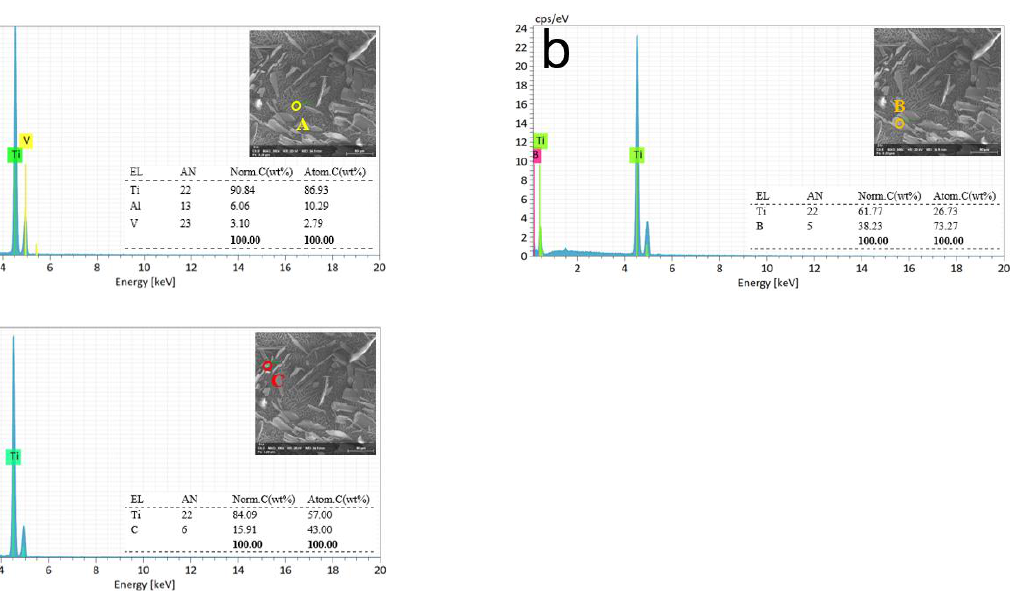
Figure 12. Energy spectrum analysis at different spots of processing time at 100 s. Different colored circles indicate measurement points at various locations. ( a ) Matrix material. ( b , c ) Reinforcing phase particles attached to the matrix.